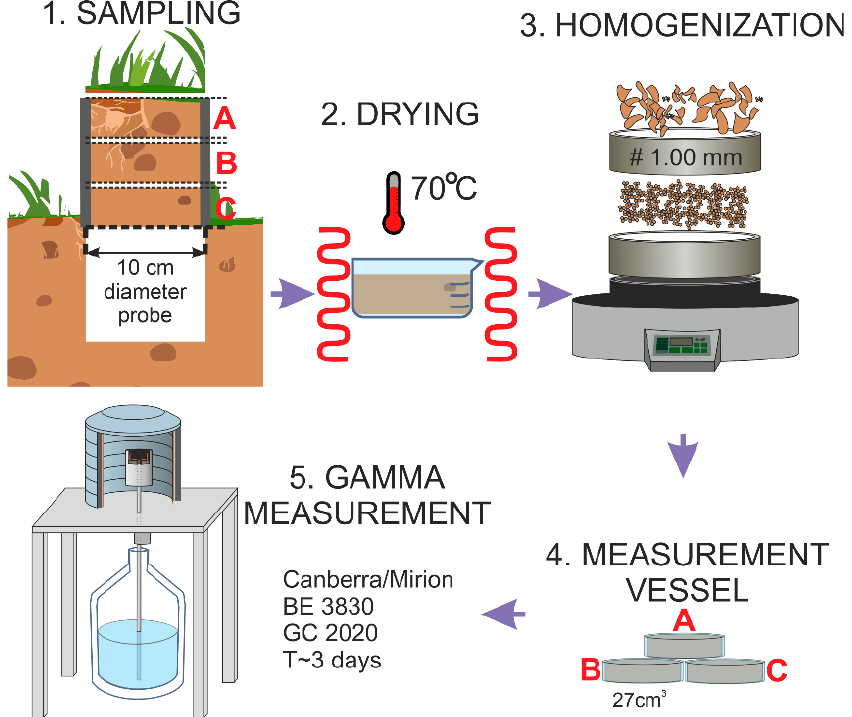
Figure 4. The procedure for sample preparation.